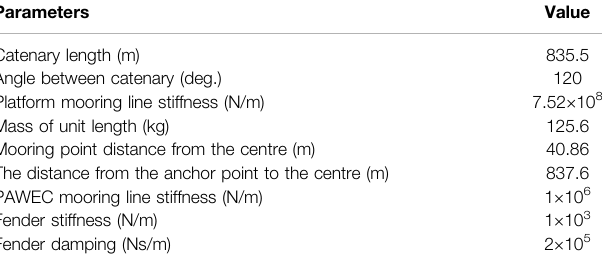
TABLE 3 | Parameters for modelling in